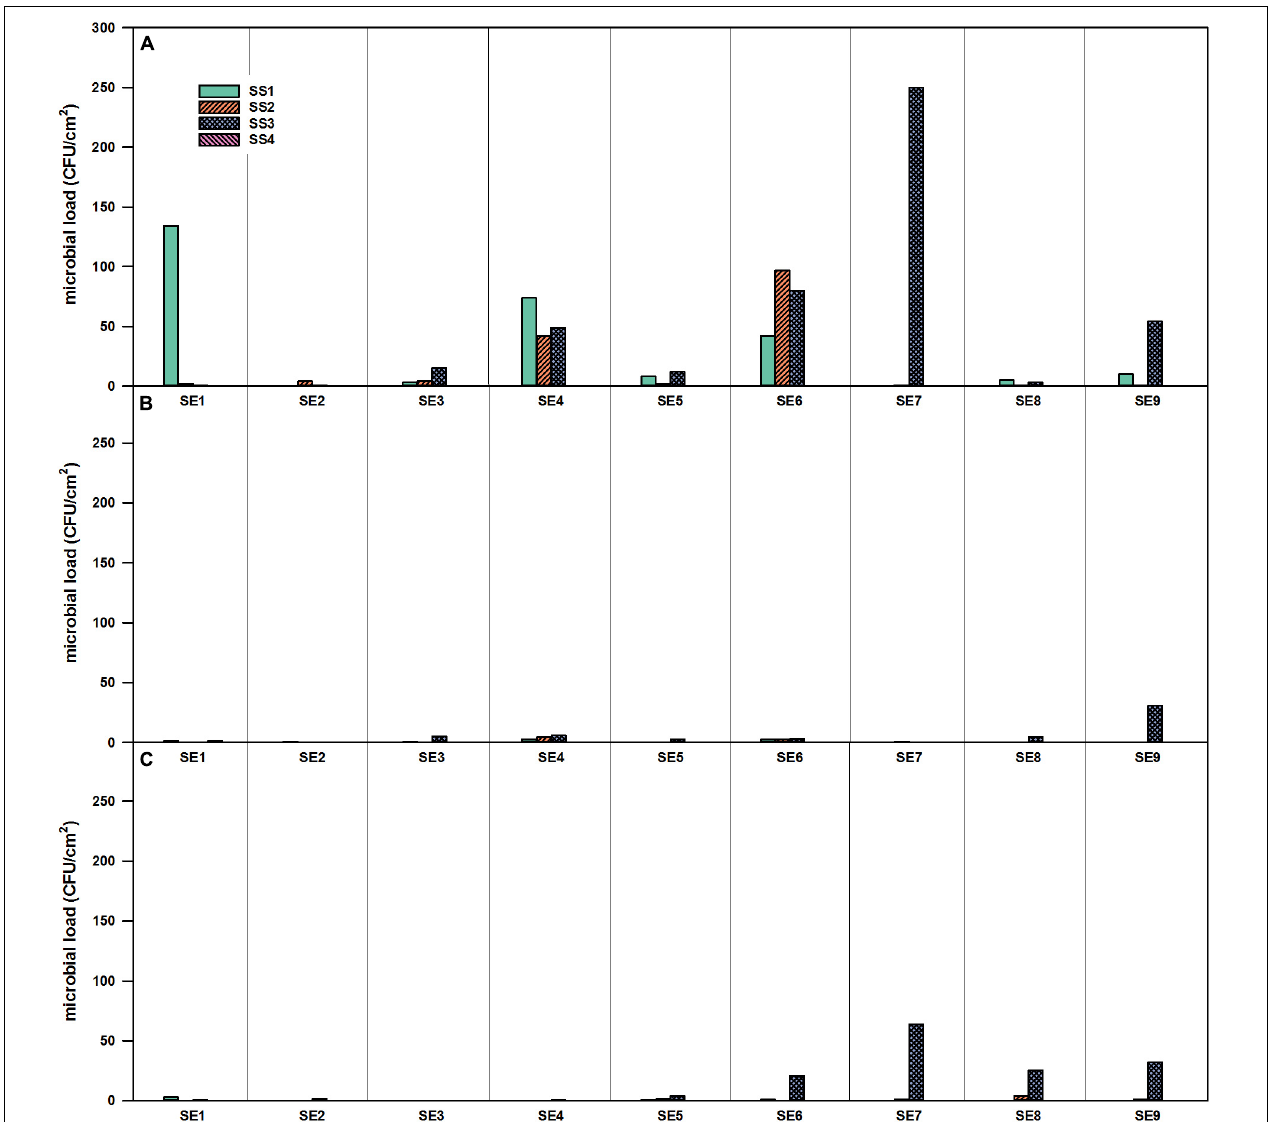
FIGURE 3 | Microbial load (CFU/cm 2 ) at four different locations in the SS of the EDEN-ISS greenhouse over the time of operation. (A) Selective R2A, (B) R2A with heat shock, and (C) selective PDA, sampling period from January to November 2018.